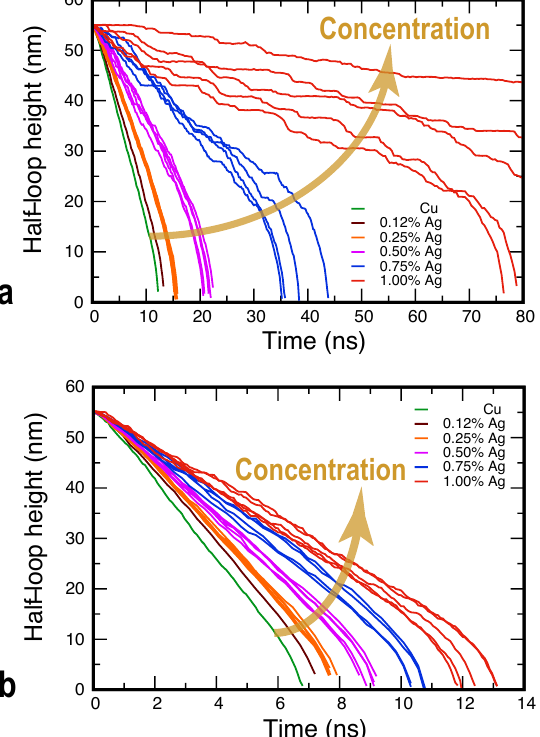
Figure 4. GB dynamics in MD simulations of Cu–Ag alloys at the temperatures of ( a ) 950 K and ( b ) 1100